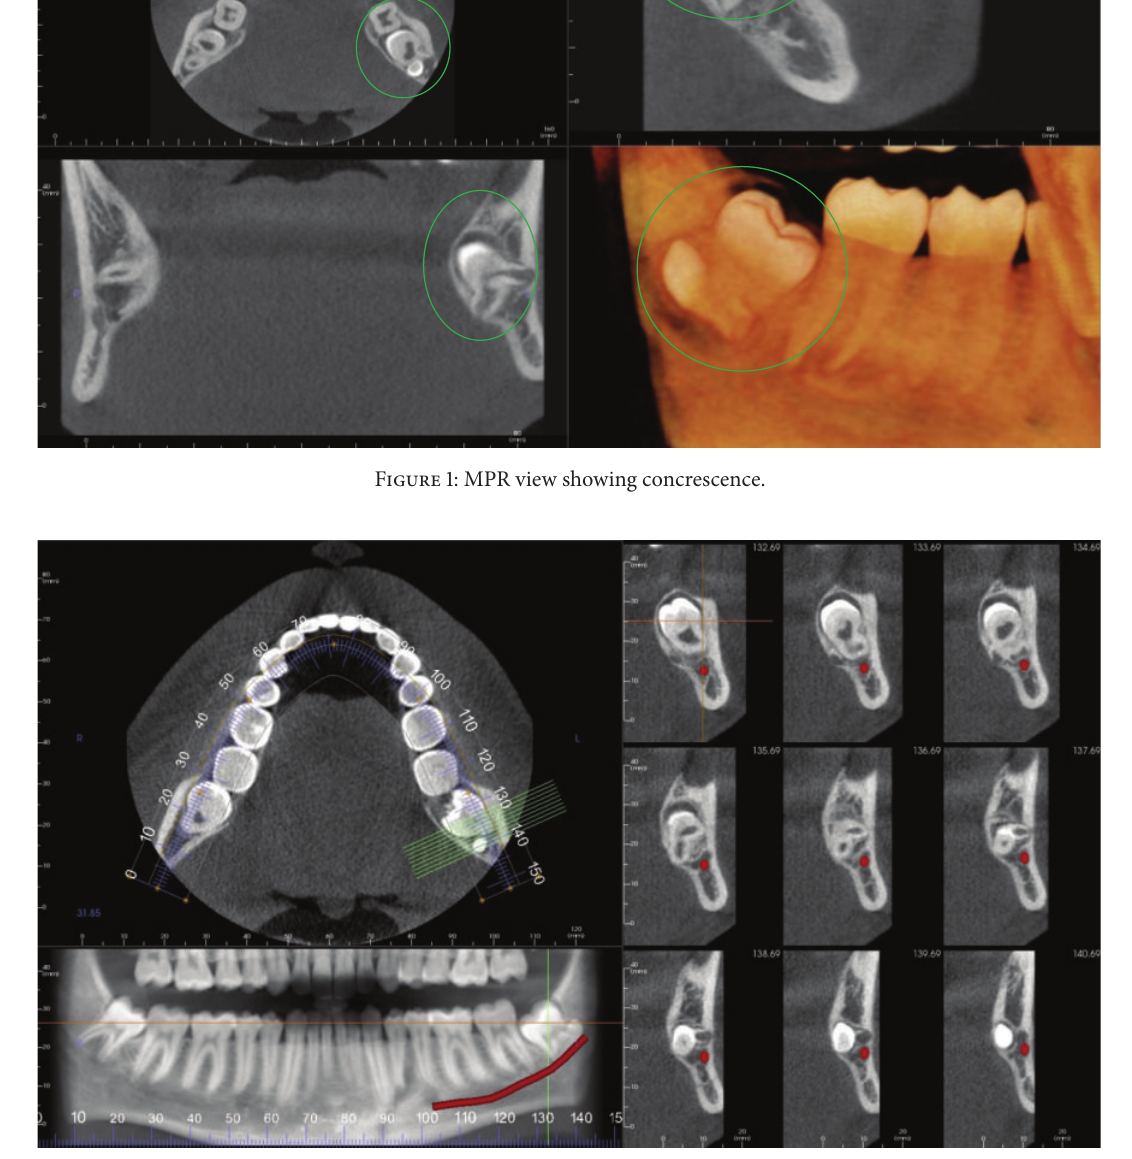
Figure 2: Panoramic radiograph and cross-sectional view proximity of the inferior canal to concrescence